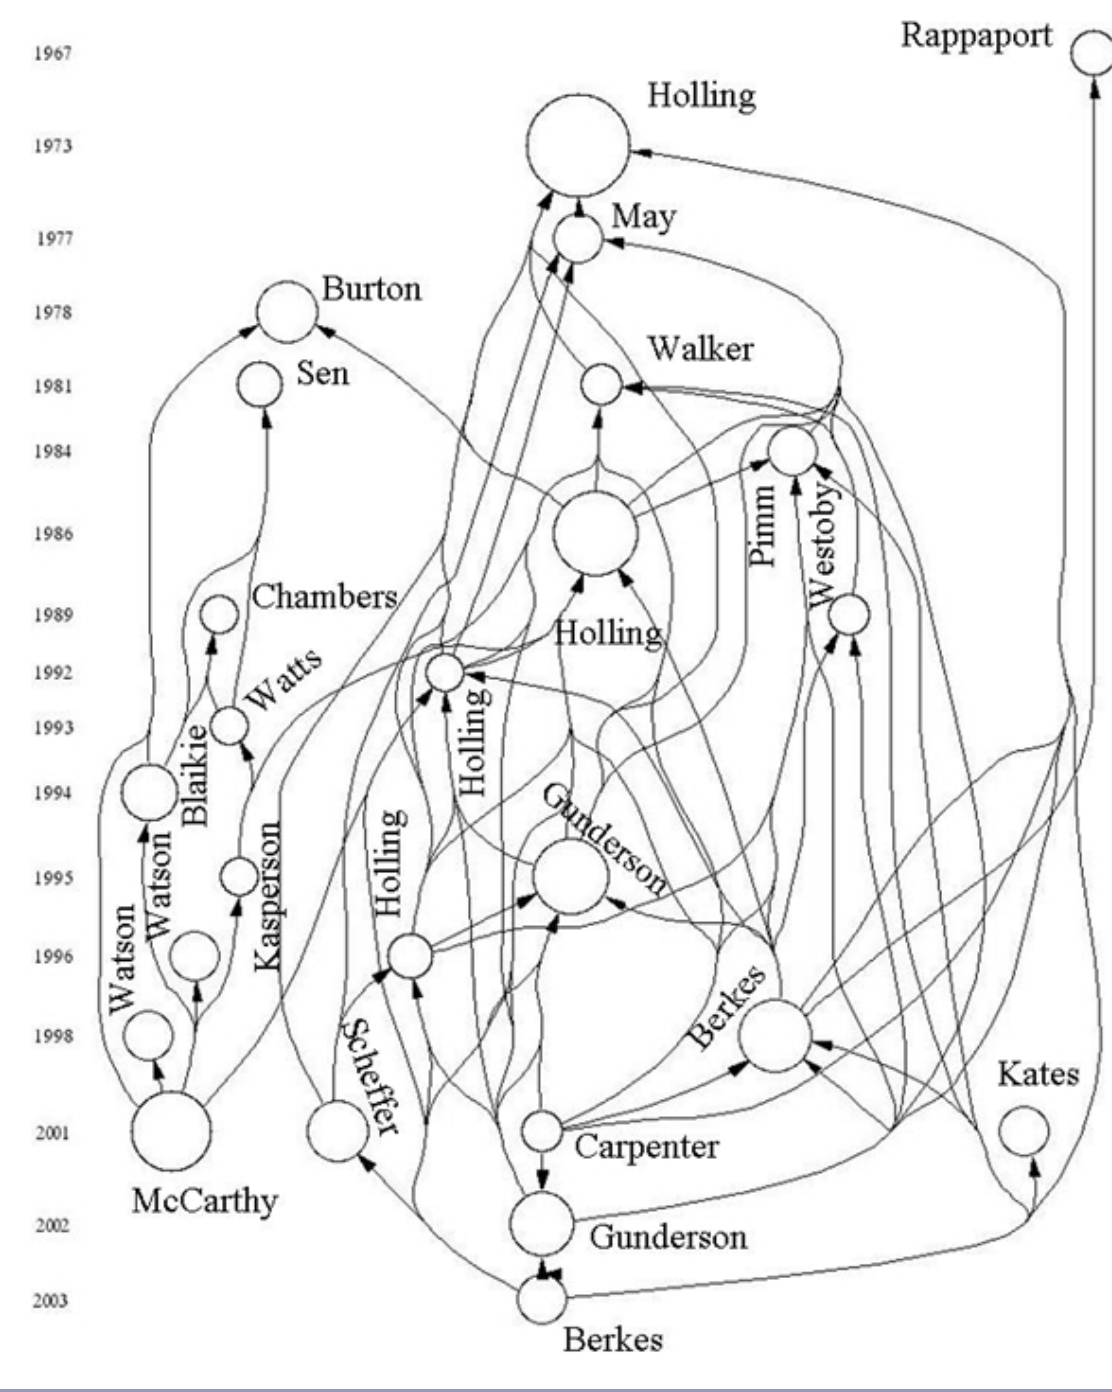
Fig. 3. Paper citation network of the most highly cited papers within the whole data set (Threshold 60 citations within the data set). The node size denotes the number of citations, the arrows refer to